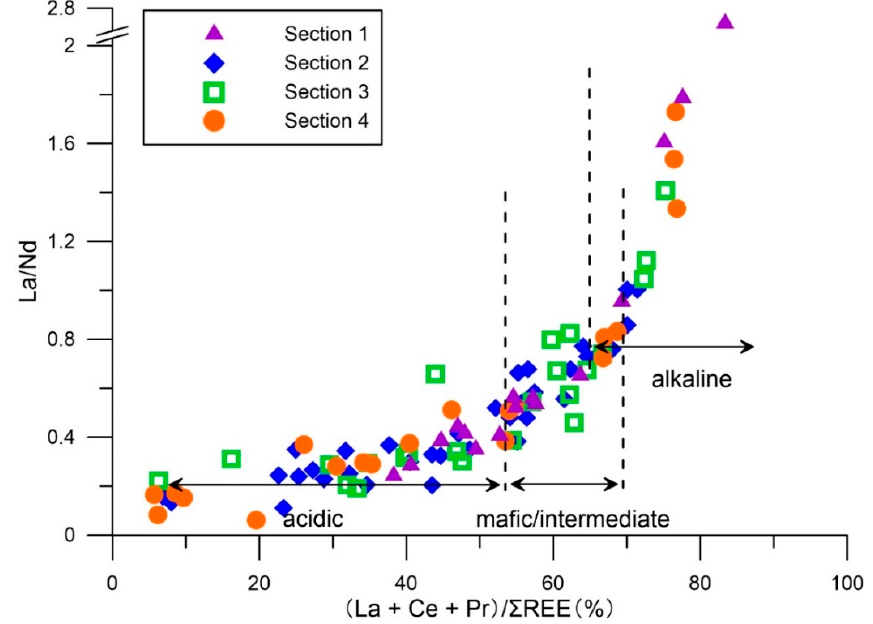
Figure 4. Detrital apatite compositions in the four sections of Core S3 from the SOT plotted on the La/Nd vs. (La + Ce + Pr)/ Σ REE (%) classification plot [65].